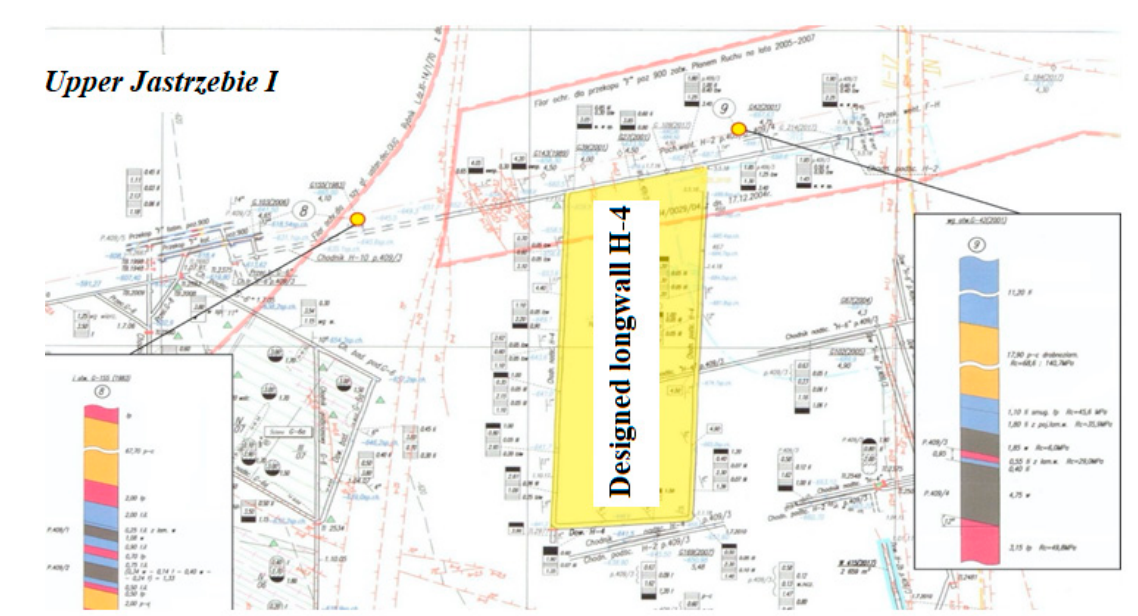
Figure 5. The map of the developed longwall H-4 in seam 409/4.